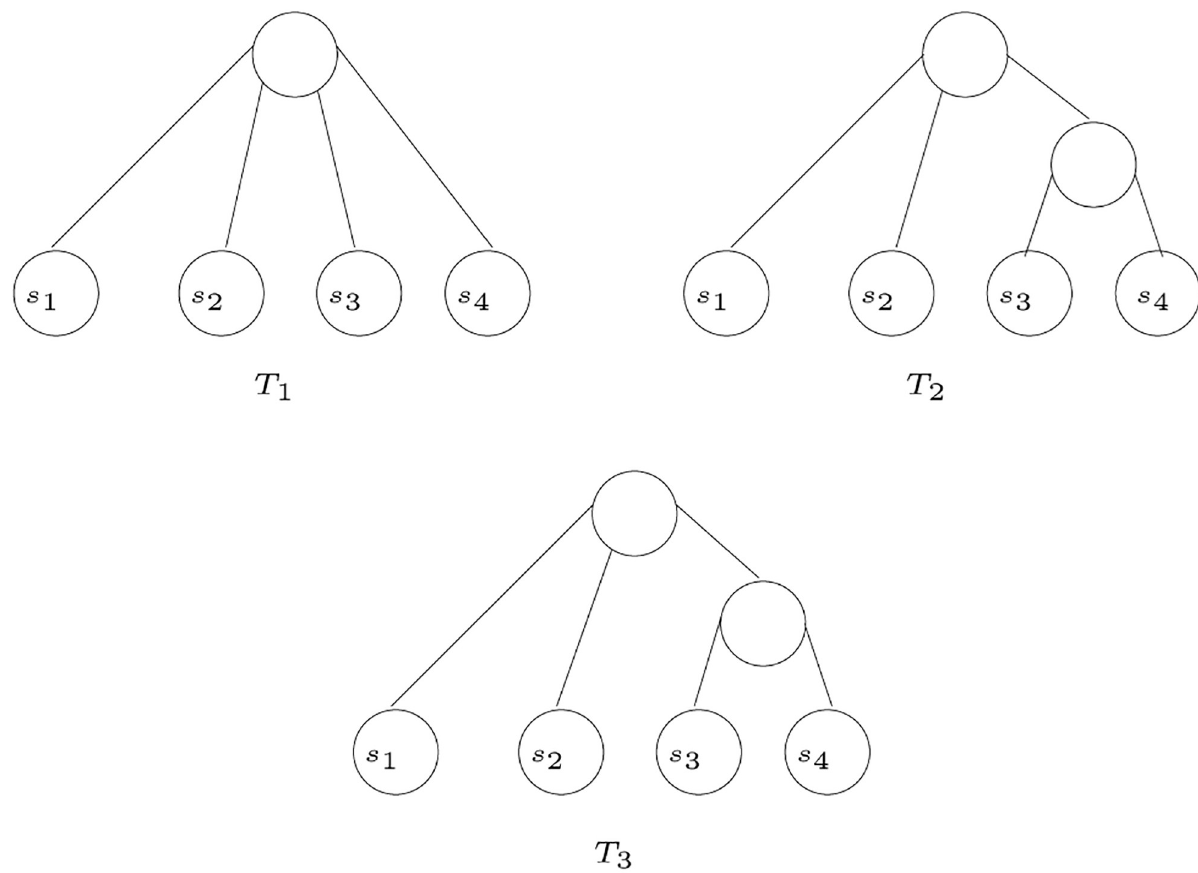
Fig 29. T 3 is the minimum common refinement of T 1 and T 2